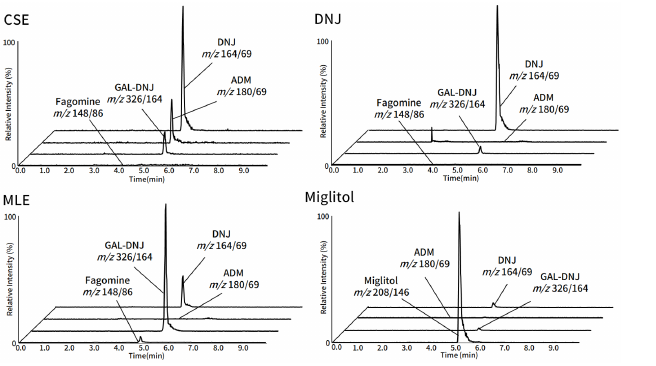
Fig 3. The chromatograms of administration samples. Aza-sugars in each sample were analyzed using LC-MS/MS.